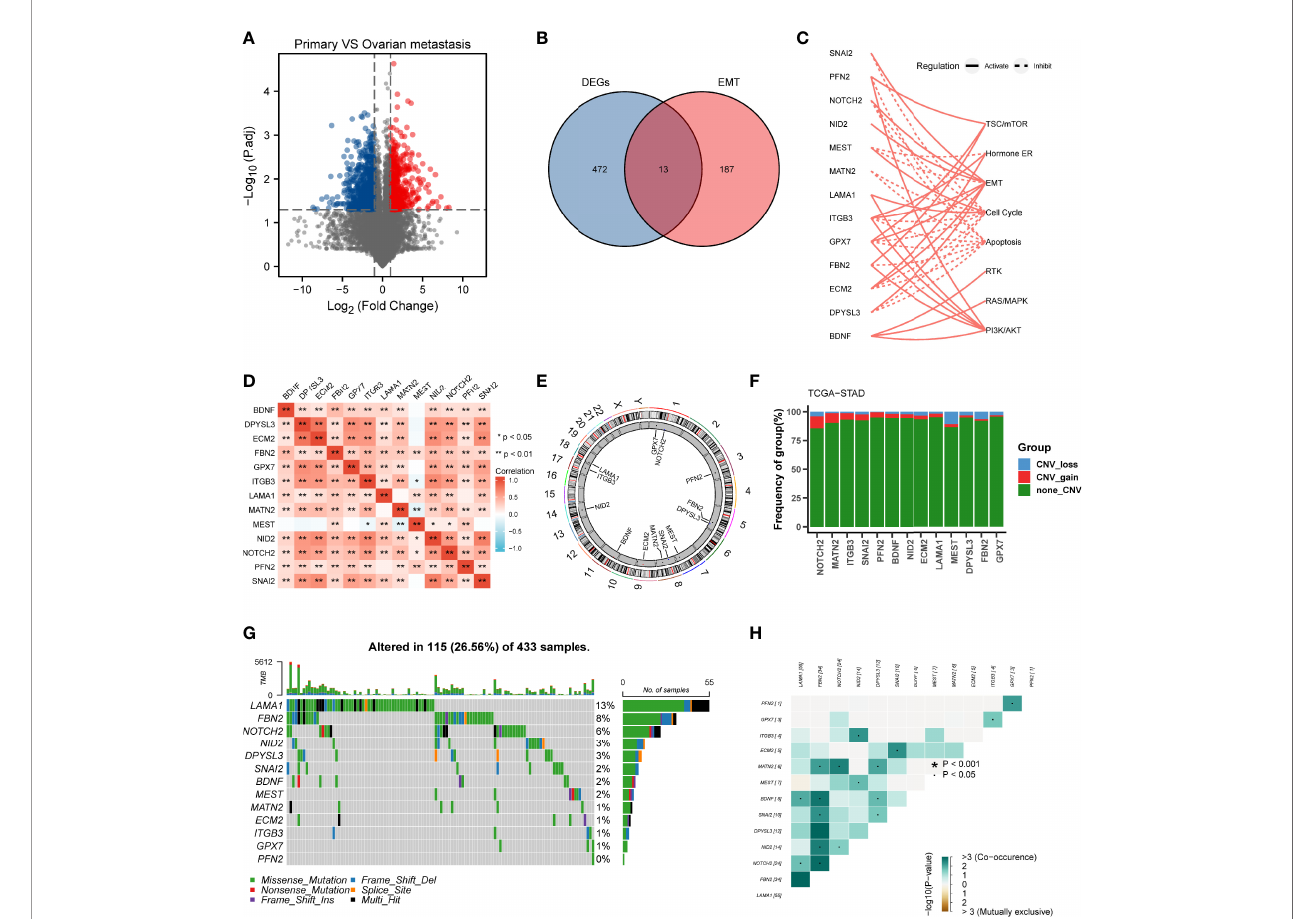
FIGURE 1 | Landscape of genetic variation and correlation of MEMTS in gastric cancer. (A) Volcano plot showing DEGs between primary gastric tumor and ovarian metastatic tumor. (B) Venn diagram showing 13 genes extracted through taking the intersection of DEGs and EMT hallmark genes. (C) The relationships between 13 genes and pathways. The solid and dashed lines denote regulation of activation and inhibition, respectively. (D) Spearman ’ s correlation analyzing the correlation among 13 genes. Orange represents positive correlation and the depth of the color represents the size of correlation coef fi cient. (E) The distribution of 13 genes in the chromosomes. (F) CNV analysis of hub genes in TCGA cohort. (G) Oncoplots showing the mutation landscape of hub genes in GC patients from TCGA database. Each column represents an individual sample. The upper and right barplots denote TMB and the proportion of each variant type respectively while the mutation frequency in each gene is displayed by the numbers on the right. (H) The correlation among mutation of 13 genes. Green represents co-occurrence of mutations in two